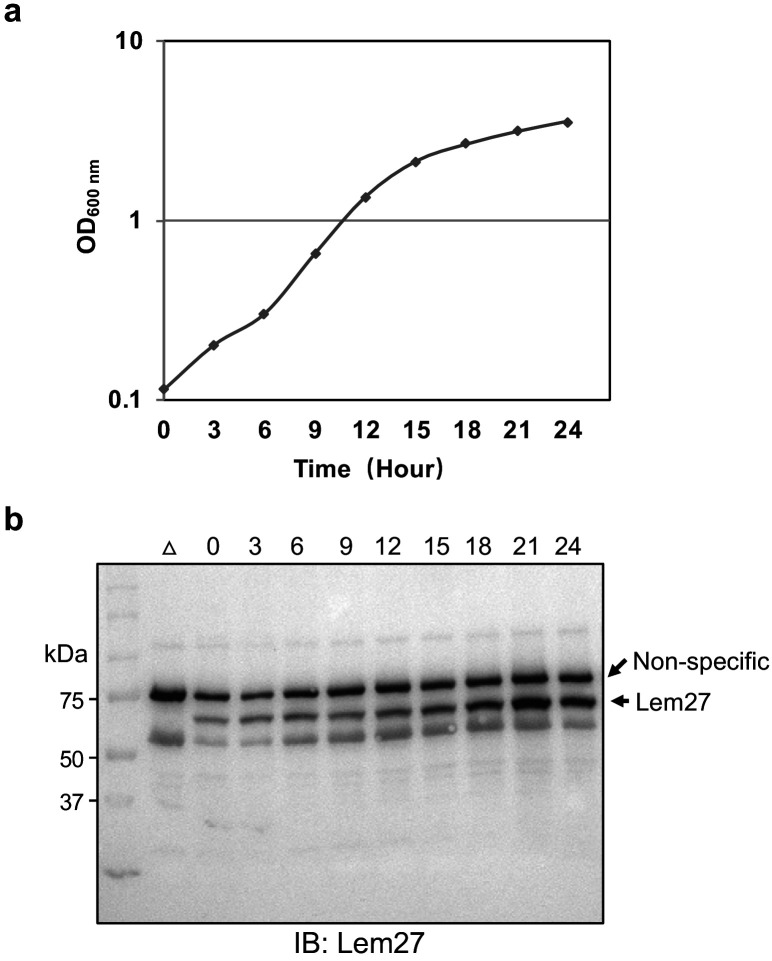
Expression of lem27 in L. pneumophila grown at different phases.The L. pneumophila strain Lp02 was grown at 37°C in a shaker, cell growth was monitored by measuring the OD600 and continued for 24 hr. The expression level of lem27 was monitored throughout the culture by withdrawing equal amounts of cells at the indicated times. Total proteins resolved by SDS-PAGE were detected by immunoblotting with Lem27-specific antibodies. The ∆lem27 mutant grown at the post-exponential phase was included to identify the protein band representing Lem27. The band above the target protein recognized nonspecifically by the Lem27 antibodies was used as a loading control.